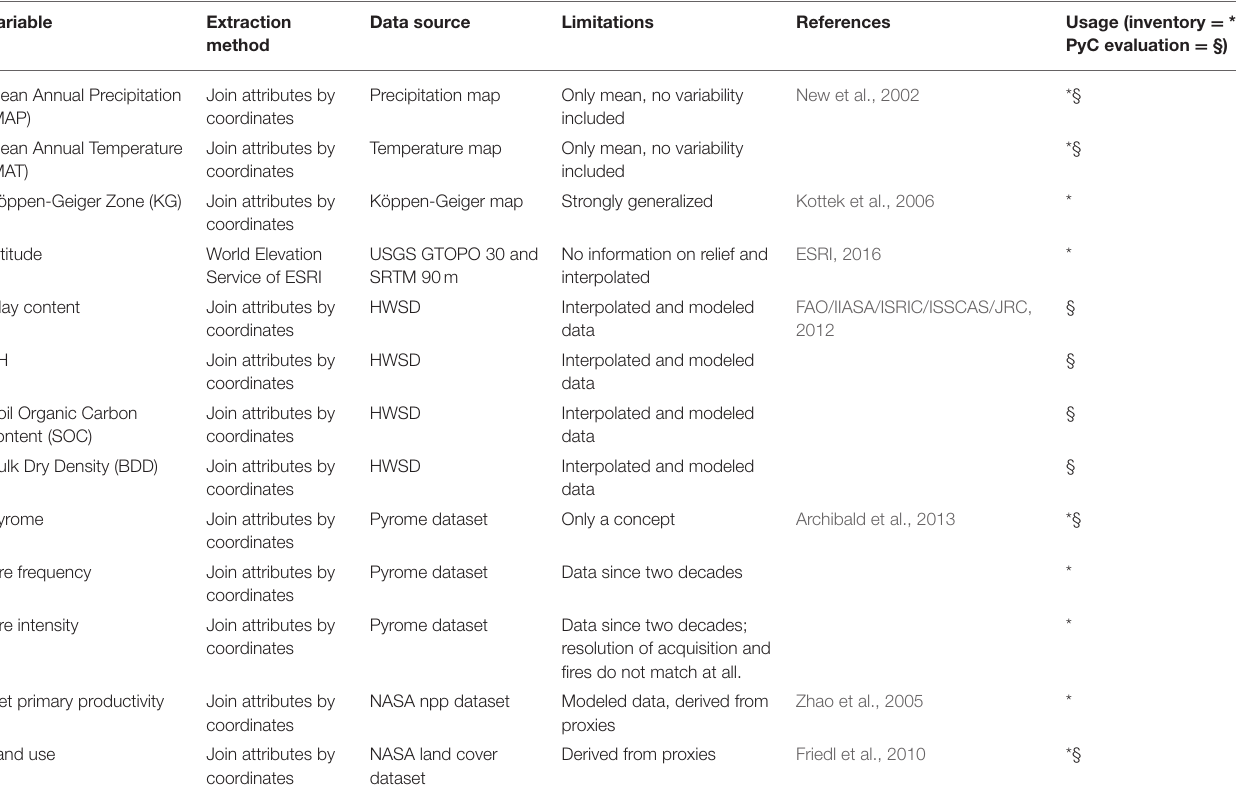
TABLE 2 | Datasets used to fill missing values or add additional investigated